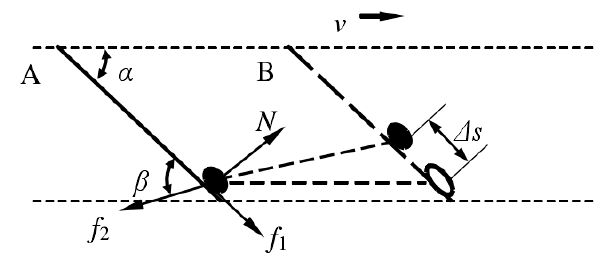
Figure 12. Stress analysis of soil particles